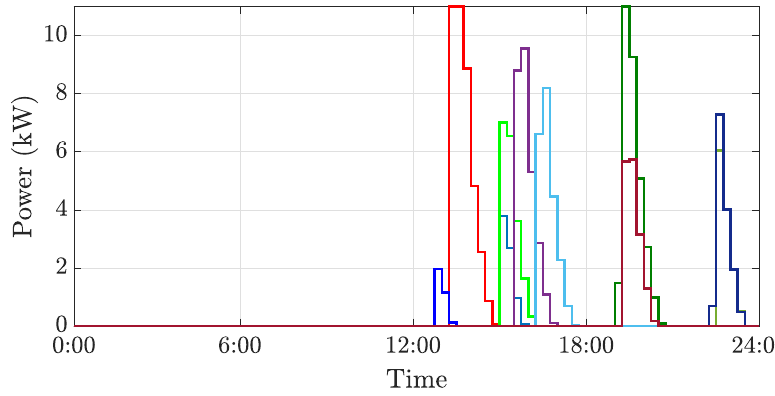
Figure 2. Exemplary profiles for EV charging with 11kW.